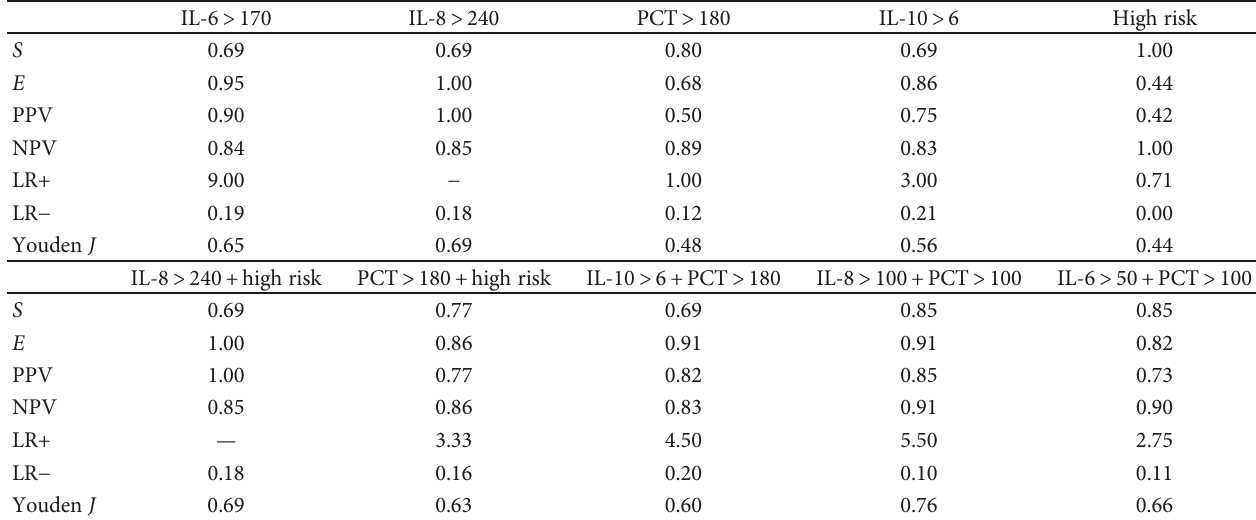
Table 7: Performance of cuto ff values and combinations of the biomarkers IL-6, IL-8, IL-10, and PCT (all in pg/mL) as sepsis discriminators on day 1 of fever, compared with the high-risk assessment model. S =sensitivity; E =speci fi city; PPV=positive predictive value; NPV =negative predictive value; LR+=positive likelihood ratio; LR − =negative likelihood